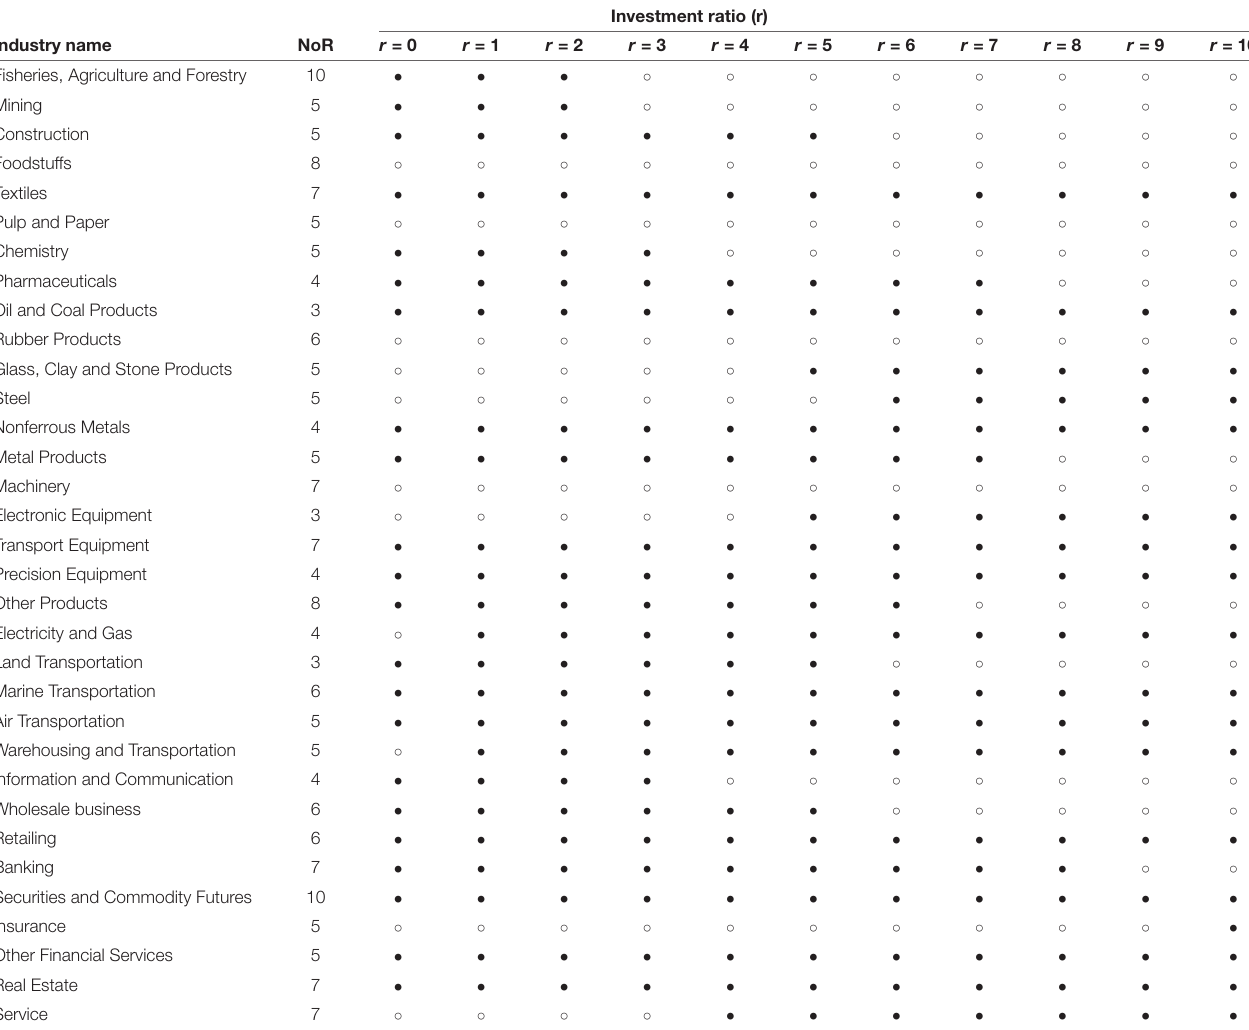
TABLE 5 | Winners and losers of proposed strategies in benchmarking